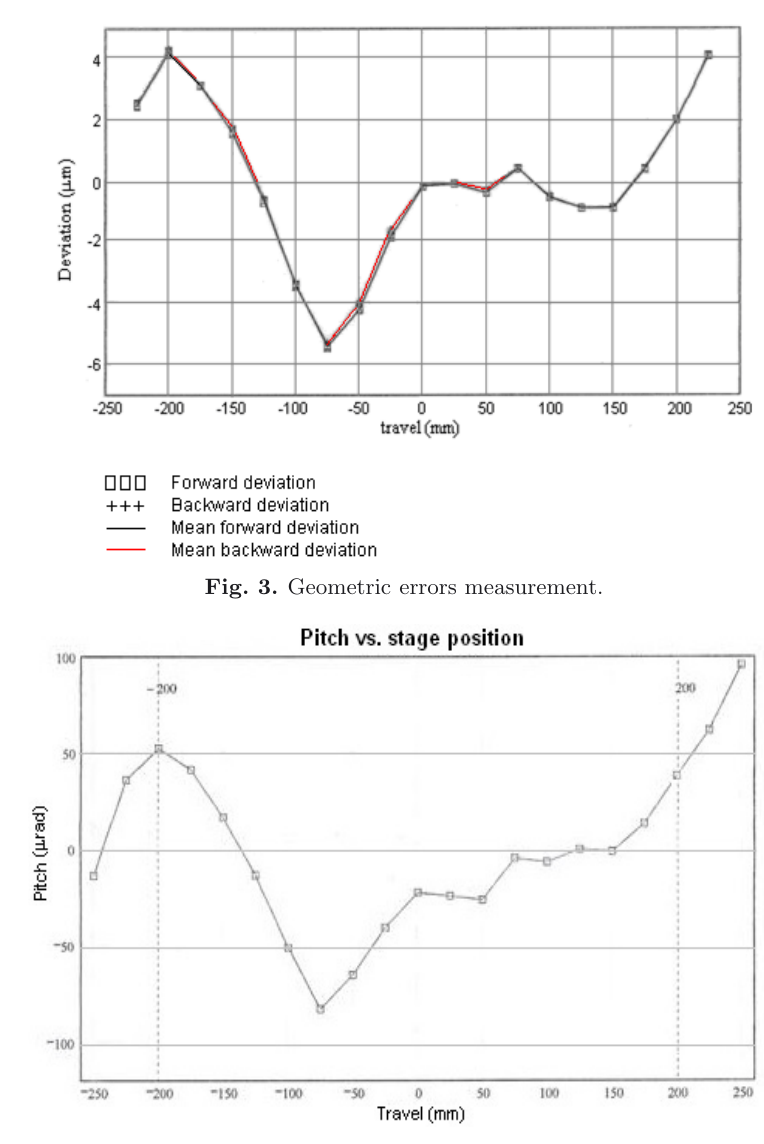
Fig. 4. Pitch vs. stage position over the 500 mm